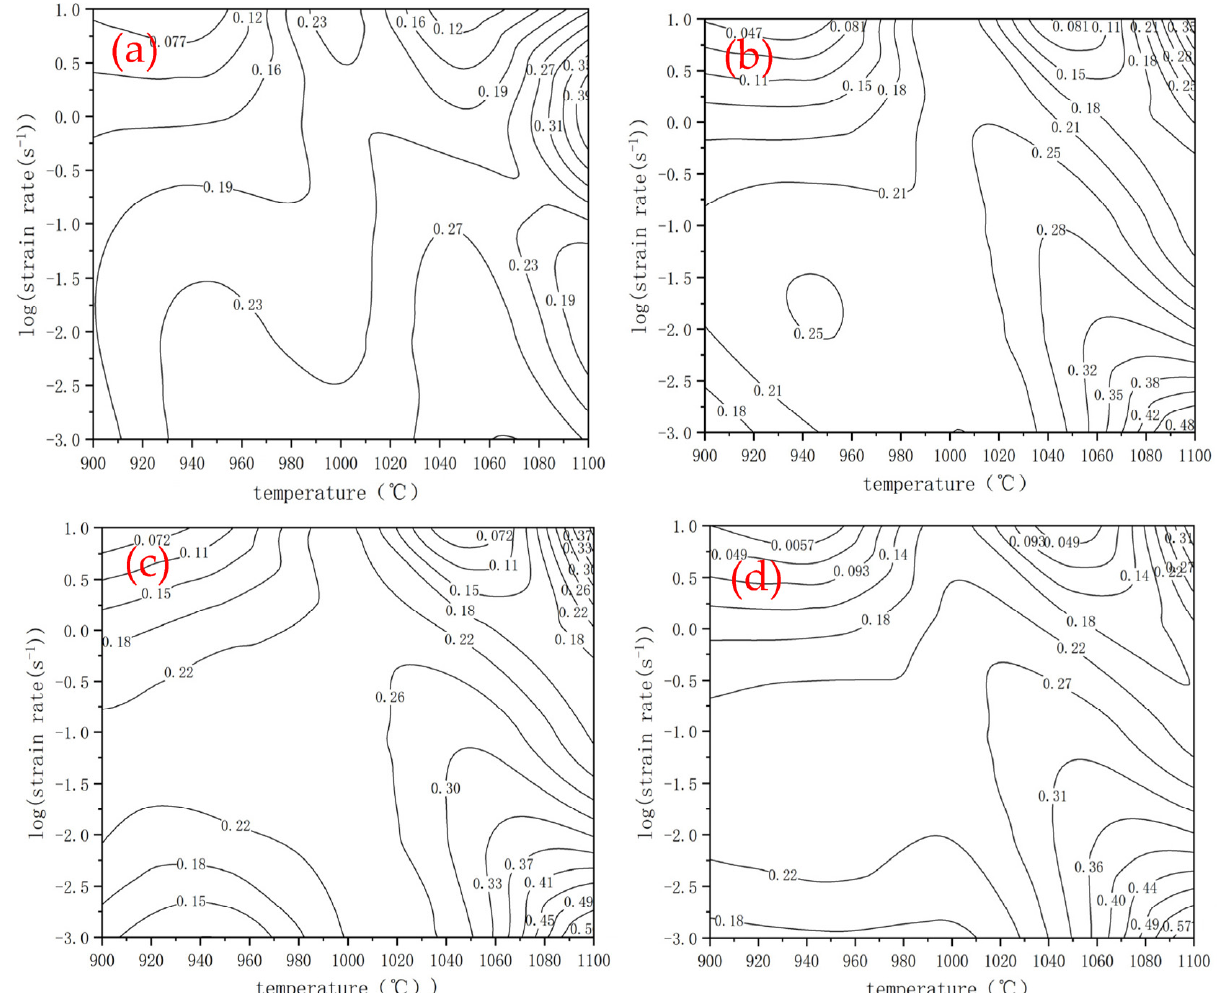
Figure 6. Energy dissipation map under different true strains: ( a ) 0.1, ( b ) 0.2, ( c ) 0.3, and ( d )